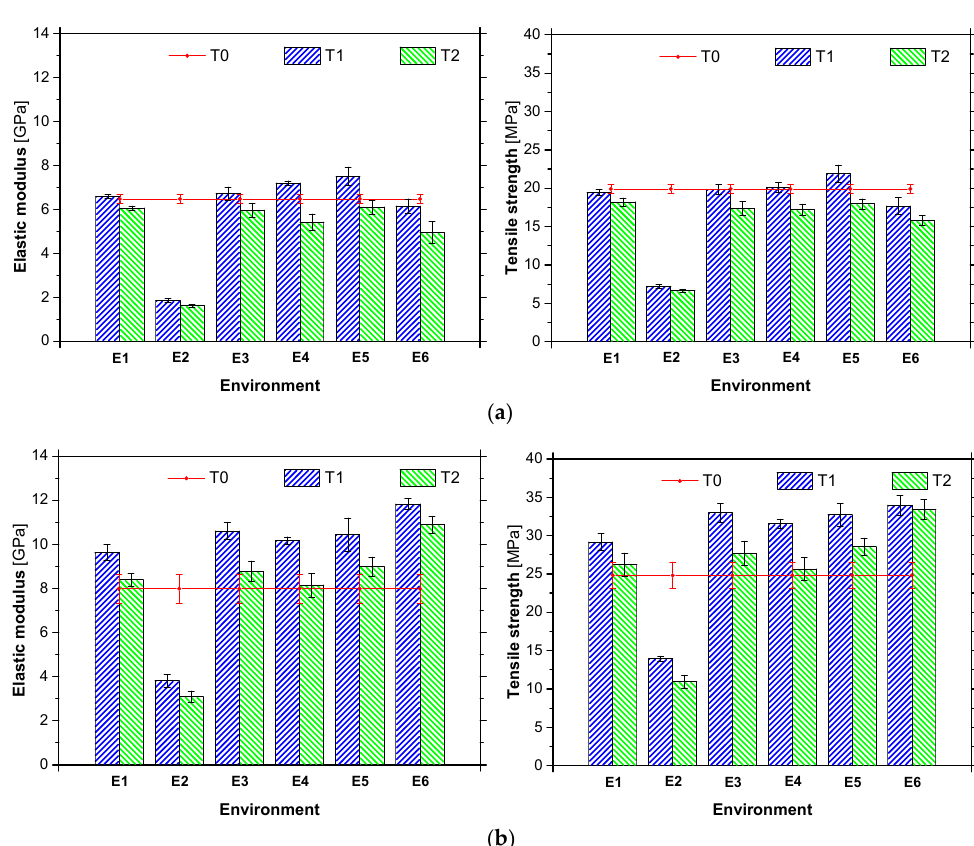
Figure 12. Elastic modulus and tensile strength of adhesives ( a ) ADH1 and ( b ) ADH2, after one (T1) and two (T2) years of exposure to the environment studied (E1 to E6), including the reference (T0).